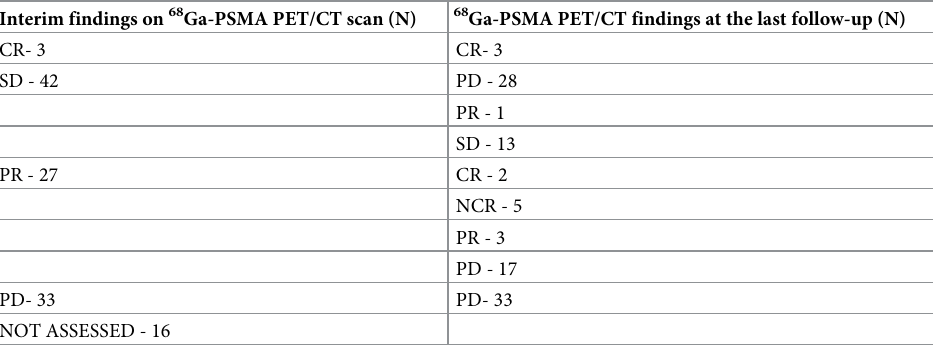
Table 5. Molecular response findings at during the 177 Lu-PSMA RLT and at last follow-up. Interim findings on 68 Ga-PSMA PET/CT scan (N)